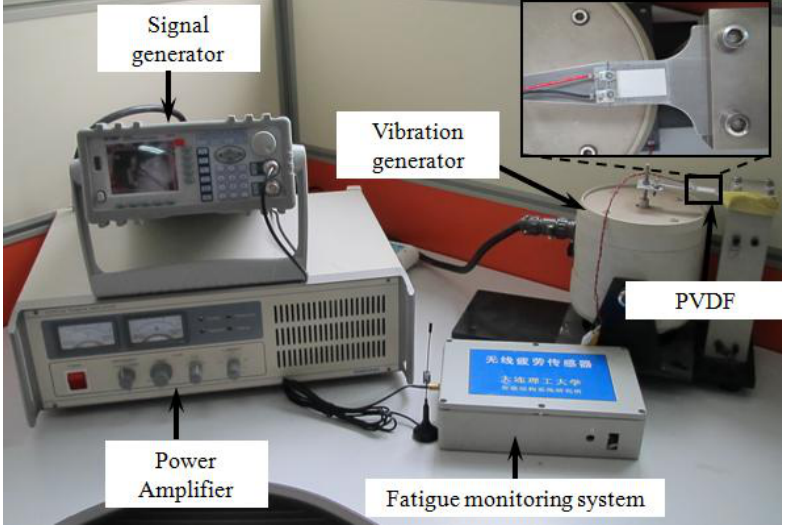
Figure 20. Experimental setups of fatigue tests based on PVDF